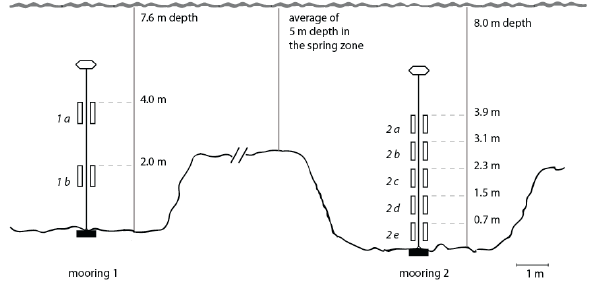
Fig. 3. Schematics of the two moorings with pairs of cylinder sed- Fig. 3: Schematics of the two moorings with pairs of cylinder sediment traps (with 2 iment traps (with indicated distance from ground) deployed in two indicated distance from ground) deployed in two local depressions in the spring zone. 3 local depressions in the spring